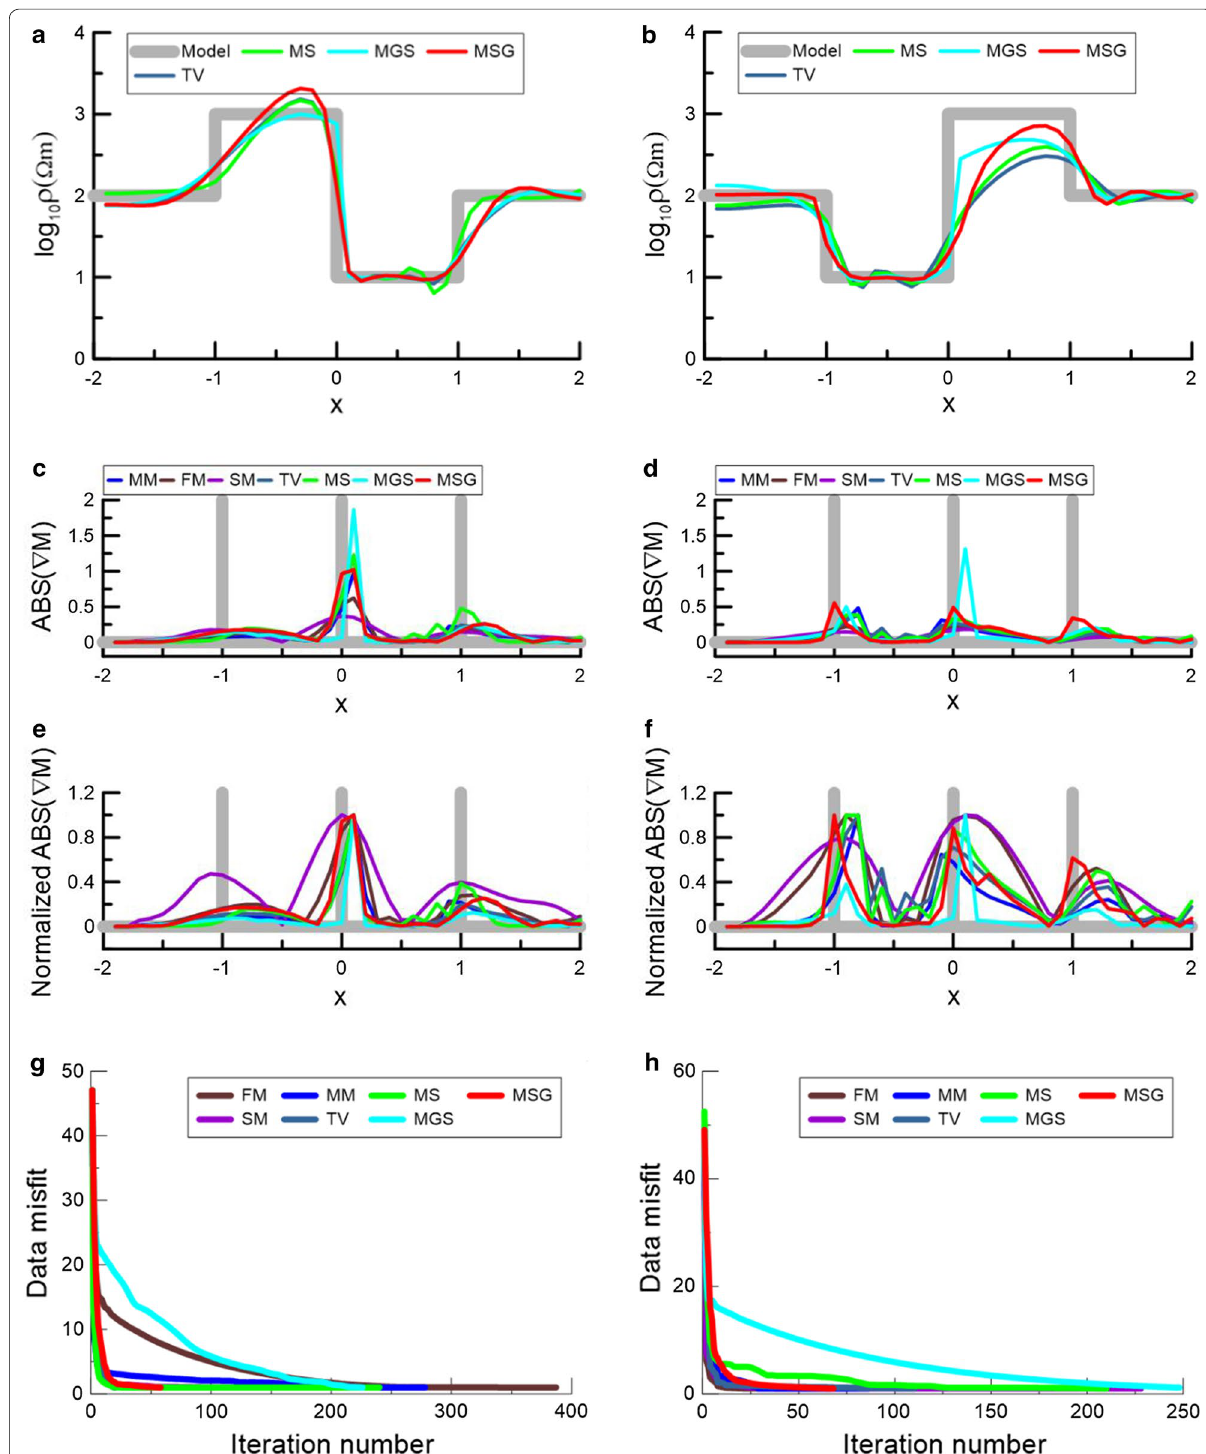
Fig. 3 1D-layered model inversion results of different stabilizing functionals with β 2 the model B, c , d the gradient of the each results, e , f normalized gradient of each results, and g , h convergence of RMS data misfit of each